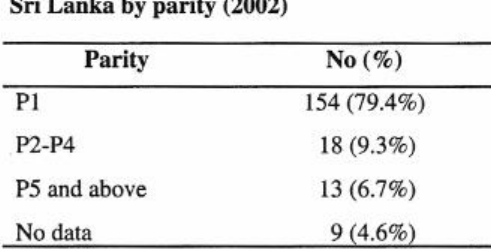
Table 5 - Distribution of Maternal deathsin Sri Lanka by parity